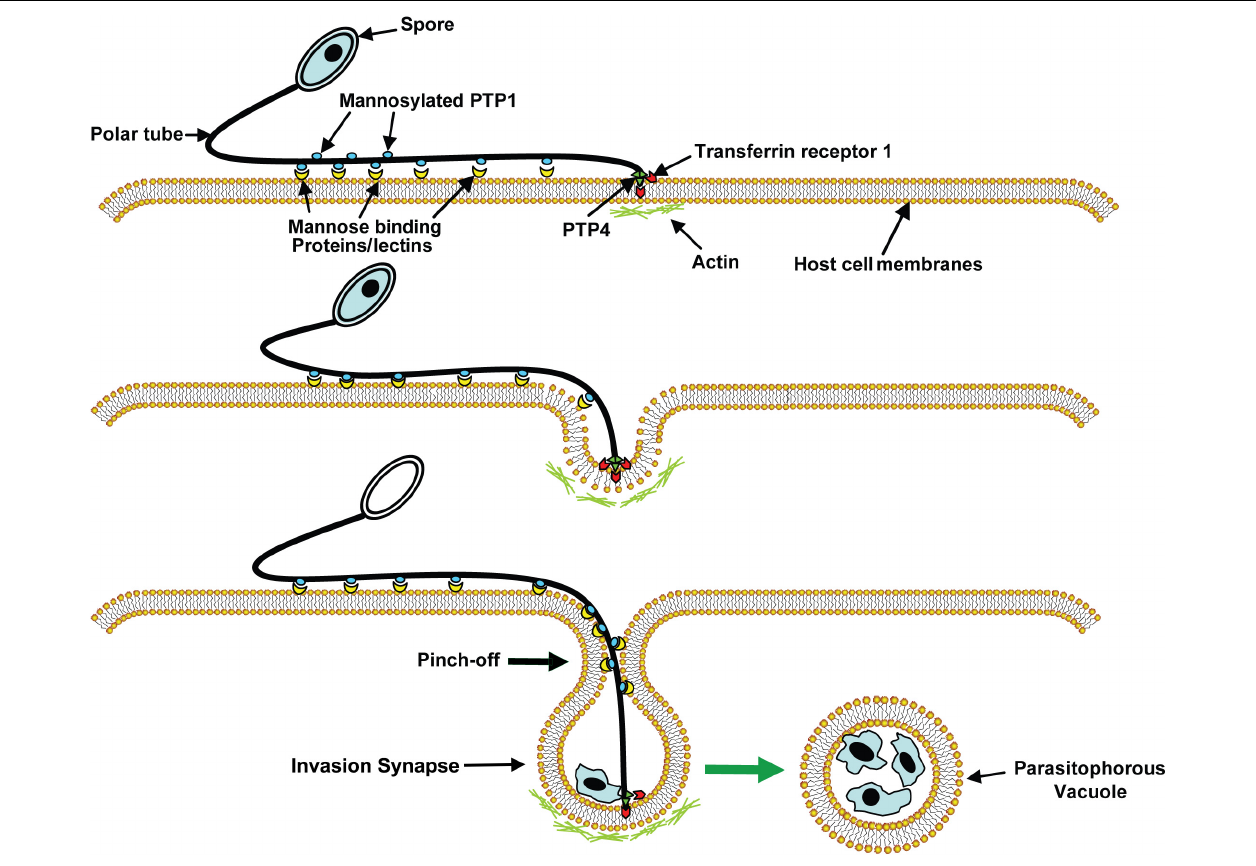
FIGURE 3 | A model of microsporidia invasion of a host cell. Polar tube protein 1 (PTP1) interacts with mannose binding proteins (MBPs) on the host surface adhering the PT to the host surface allowing the PT to form an invasion synapse by pushing into the host cell membrane. Interactions of PTP1 (and possibly PTP4) with the host cell membrane in the invasion synapse exclude the external environment from the invasion synapse creating a protected microenvironment for the extruded microsporidian sporoplasm. Polar tube protein 4 (PTP4) epitopes at the tip of PT interact with Transferrin receptor 1 (TfR1) or other host cell interacting proteins (HCIPs) on the host cell surface triggering signaling events such as clathrin-mediated endocytosis and the involvement of host cell actin in the final invasion event with formation of a parasitophorous vacuole. Reprinted with permission of the publisher (Han et al.,